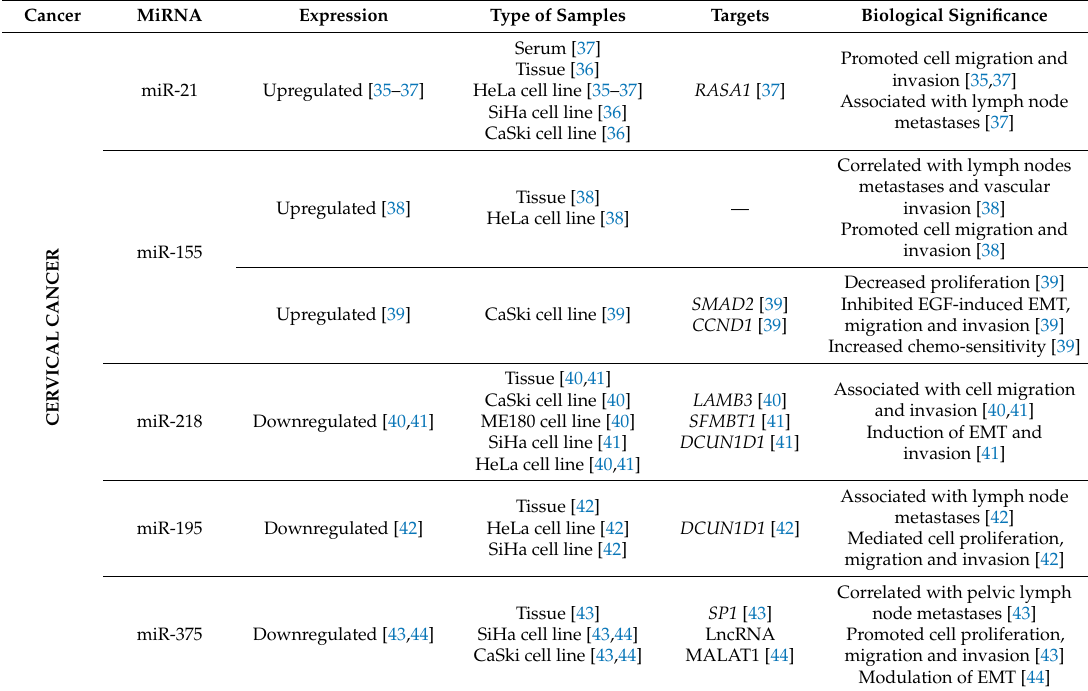
Table 1. MetastamiRs in cervical